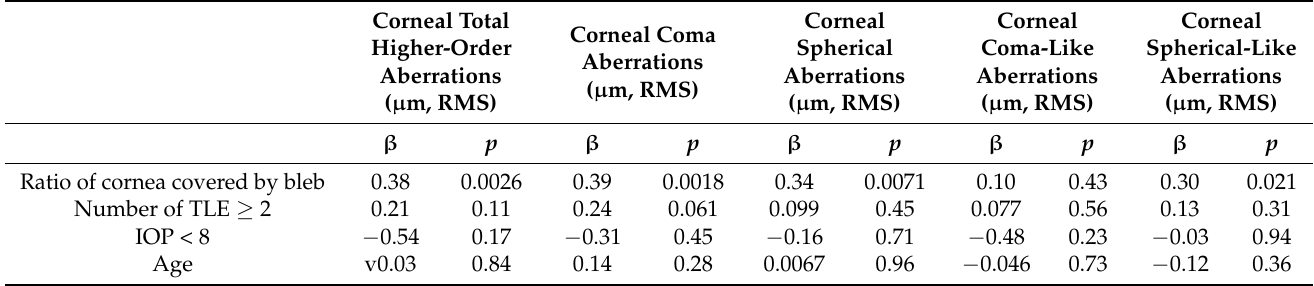
Table 4. Univariate regression analysis of corneal higher-order aberrations with associated factors in overhanging bleb eyes.